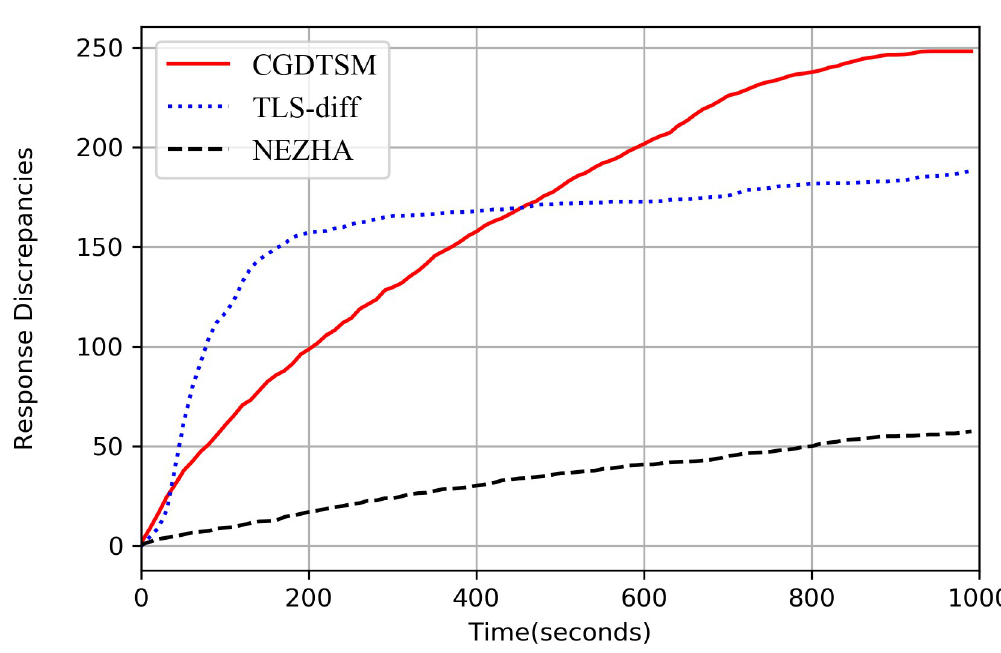
Fig 2. Comparison of three algorithms based on the “new” version. Dashed line: NEZHA, dotted line: TLS-diff, solid line: CGDTSM. The three lines represent the response difference obtained by the three methods in 1000 seconds. The experimental object are OpenSSL3.0.0, LibreSSL3.2.1, and BoringSSL(3743aaf).